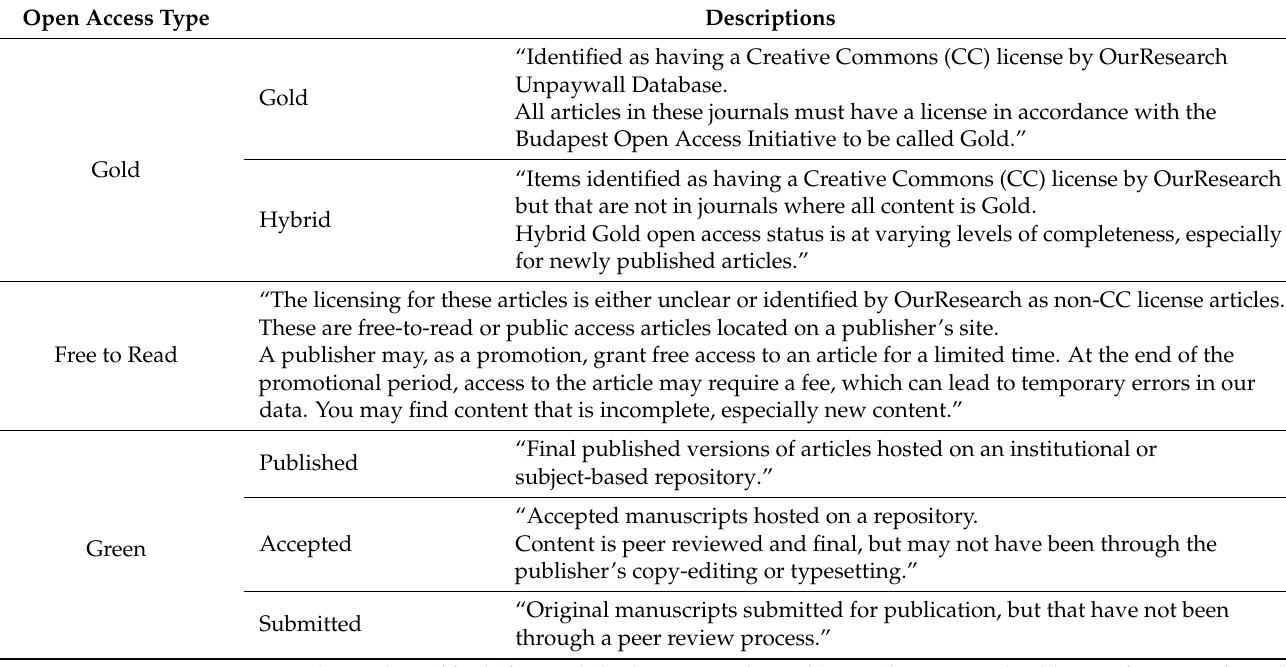
Table 2. Descriptions of open access types in WoS.